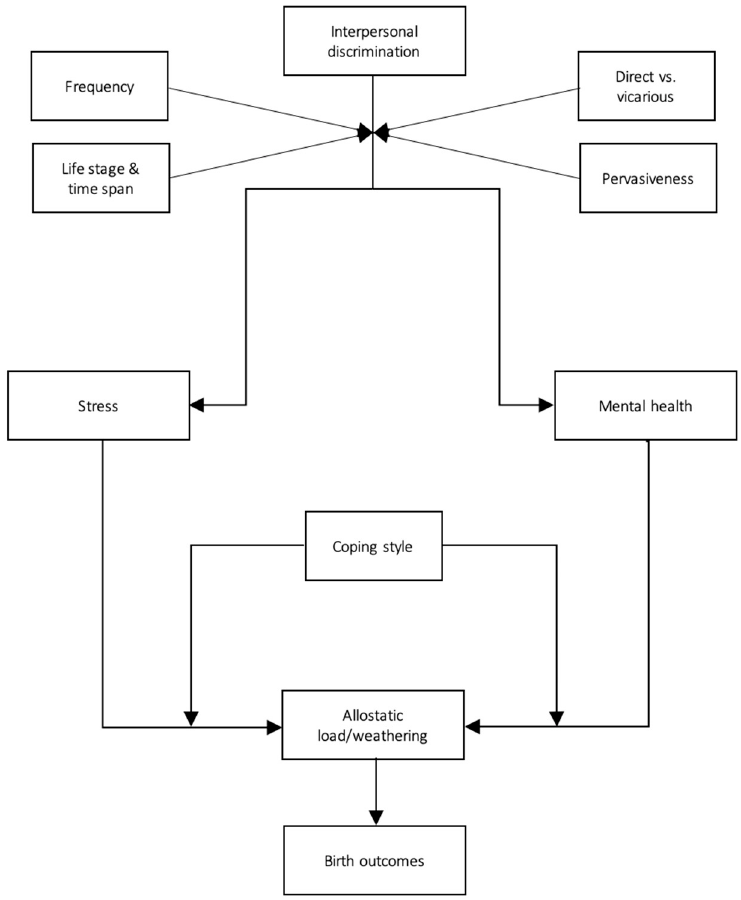
Figure 2. A preliminary, evidence-based model of the psychophysiological impact of interpersonal discrimination on birth outcomes.